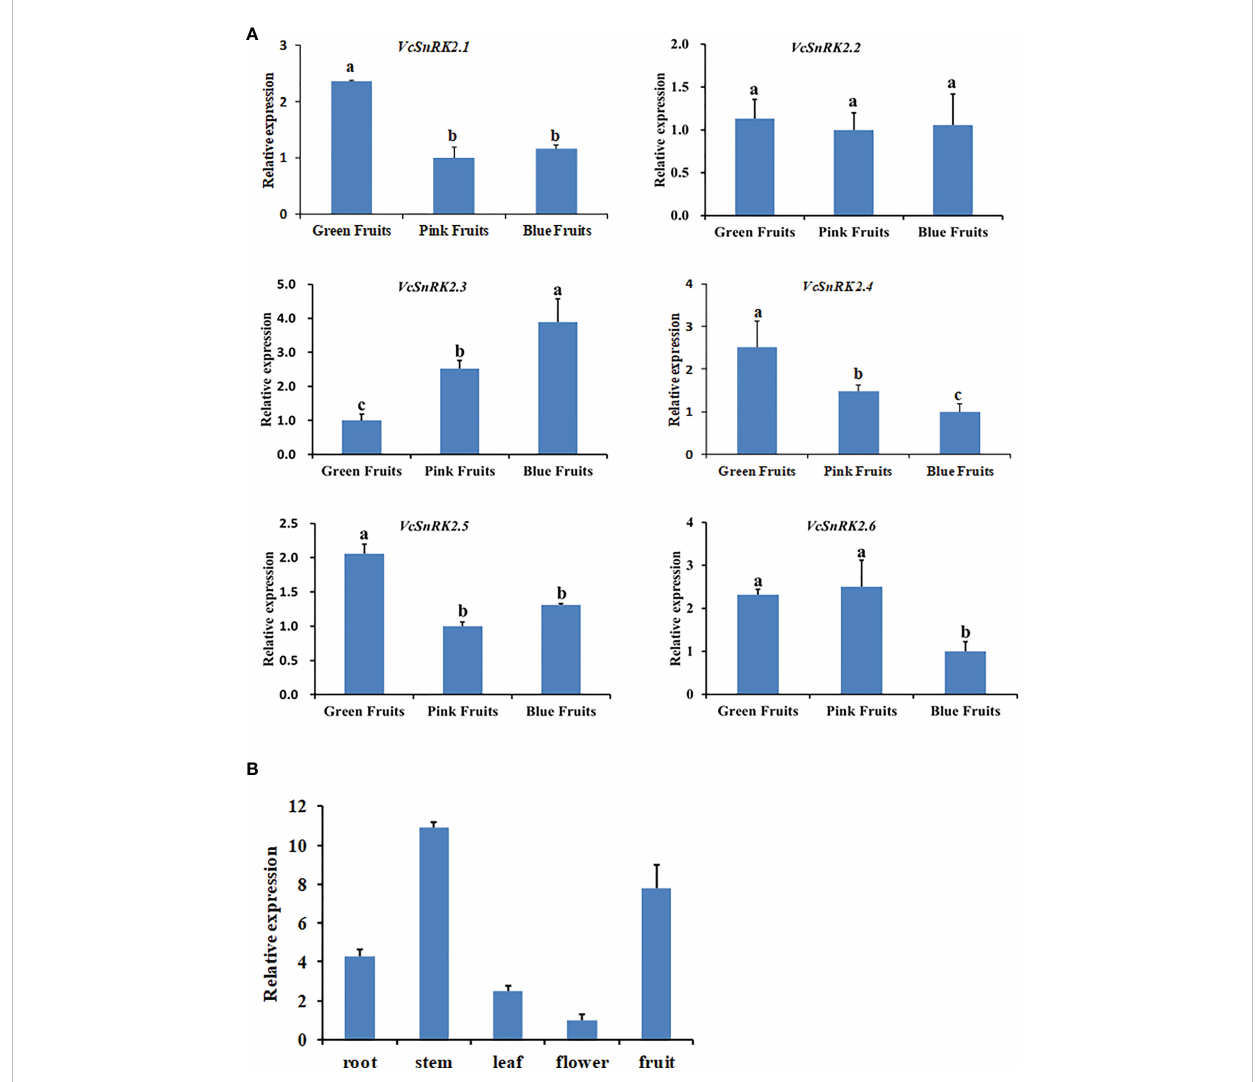
FIGURE 2 Temporospatial pattern of VcSnRK2 expression in blueberry fruits. (A) Quantitative real-time PCR (qRT-PCR) analysis of VcSnRK2.1 to VcSnRK2.6 expression in blueberry fruits at different developmental stages. Green fruits (40 days after fl owering), pink fruits (65 days after fl owering), and blue fruits (80 days after fl owering). The qRT-PCR was performed with VcGAPDH as a reference gene. Different letters above the bars indicate a signi fi cant difference based on one-way ANOVA ( P < 0.05). Values are the means + SD of three biological replicates. (B) qRT-PCR analysis of VcSnRK2.3 expression in different organs of blueberry plants. Total RNA was isolated from organs (roots, stems, leaves, fl owers and fruits). The qRT-PCR was performed with VcGAPDH as a reference gene. Values are the means + SD of three biological